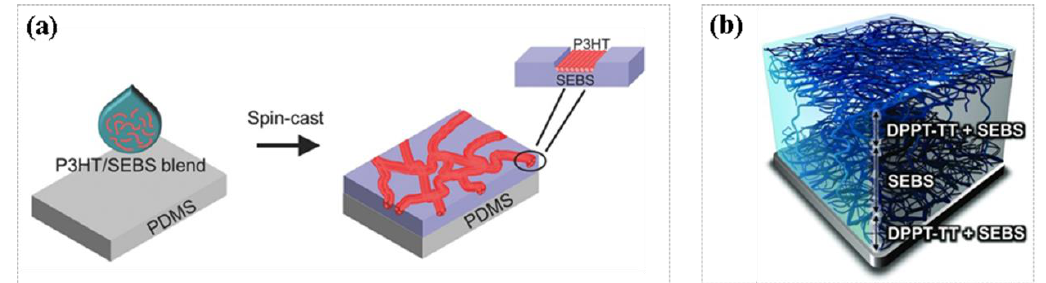
Figure 2. ( a ) Schematic diagram of P3HT and SEBS mixed in solution (left); distribution of P3HT and SEBS blend on PDMS substrate (right), the insert showed P3HT nanofibrils indented in the rubber surface [21]. ( b ) Microscopic 3D schematic of DPPT-TT and SEBS blending [22].